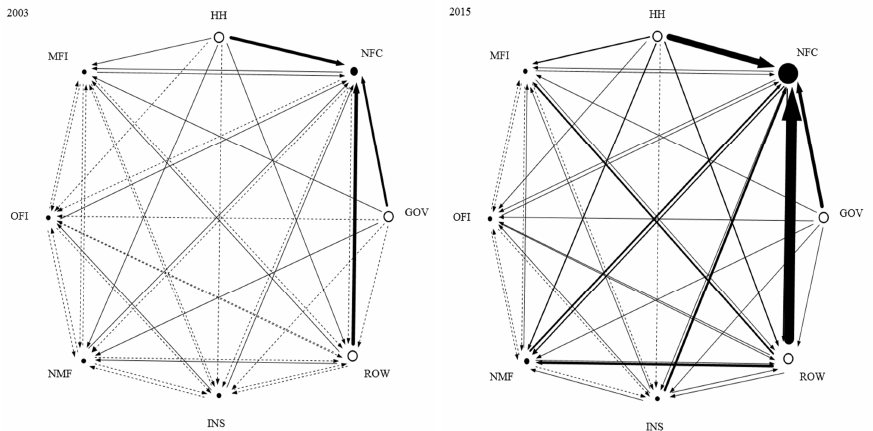
Figure 3. Flows of equity and investment fund shares in 2003 and 2015